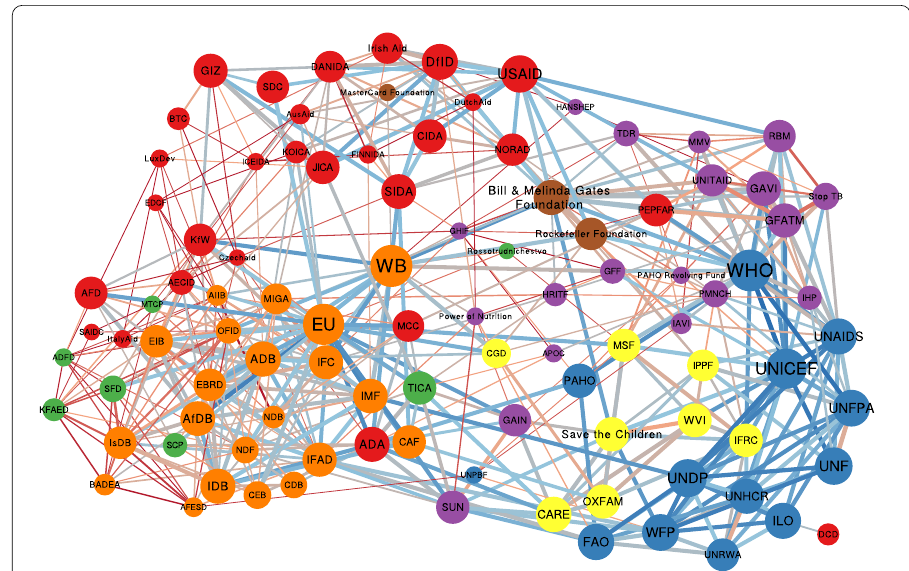
Figure 1 The organization co-citation network. Each node is an international aid organization. The node’s size is relative to its aggregate WS value. The node color reflects the organization type: red = DAC (Development Assistance Committee) bilateral; blue = United Nations; green = non-DAC bilateral; purple = health initiative; orange = multilateral; yellow = Non-Governmental Organization; brown = private philanthropy. Edges